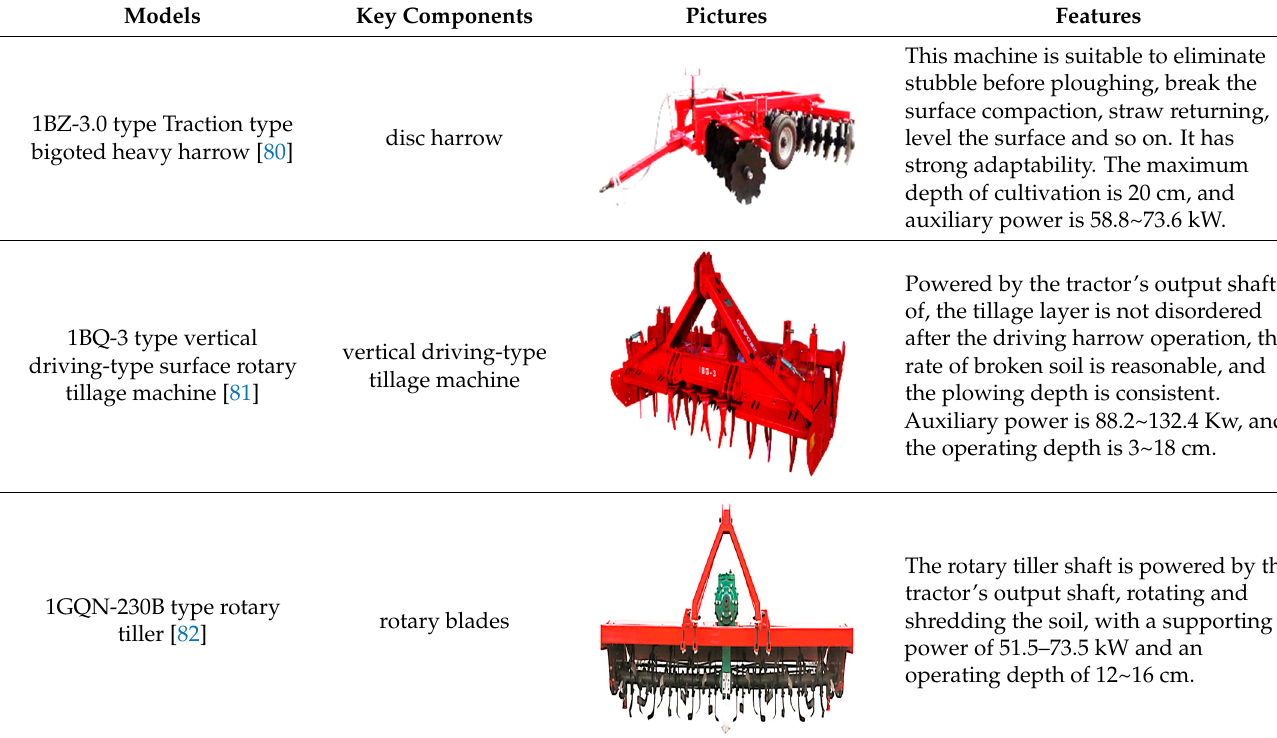
power of 51.5–73.5 kW and an operating depth of 12~16